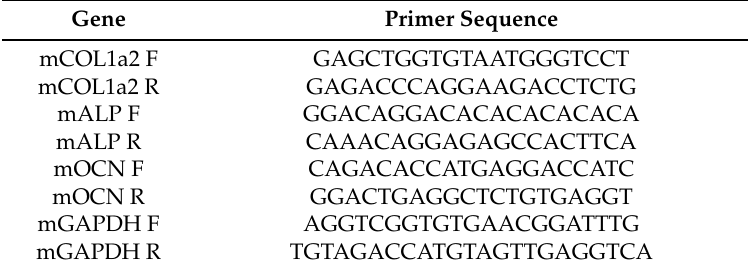
Table 1. PCR primers for genes encoding Runx2, ALP, COL1a2, BSP, OCN and